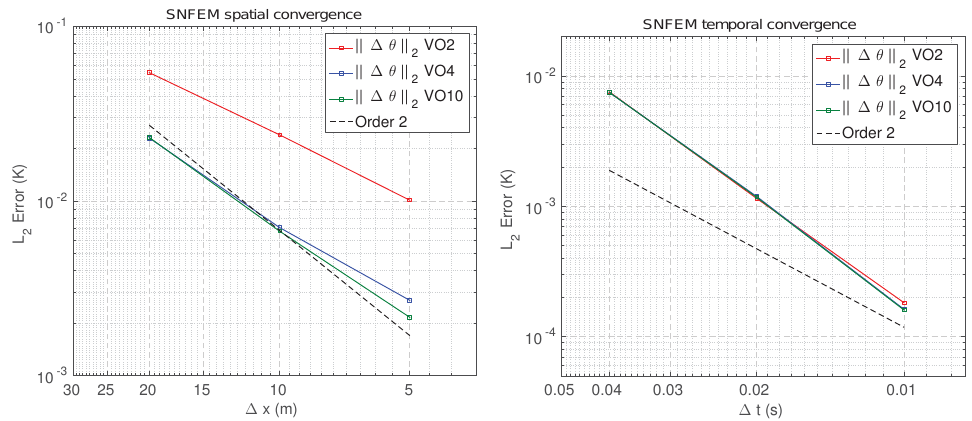
Figure 20. Spatial (left) and temporal (right) self convergence at various vertical orders of accuracy. Thermal bubble test at 200s. Spatial resolution for temporal convergence is 10m with reference (cid:49)t = 0.001s. Reference spatial resolution is (cid:49)x =